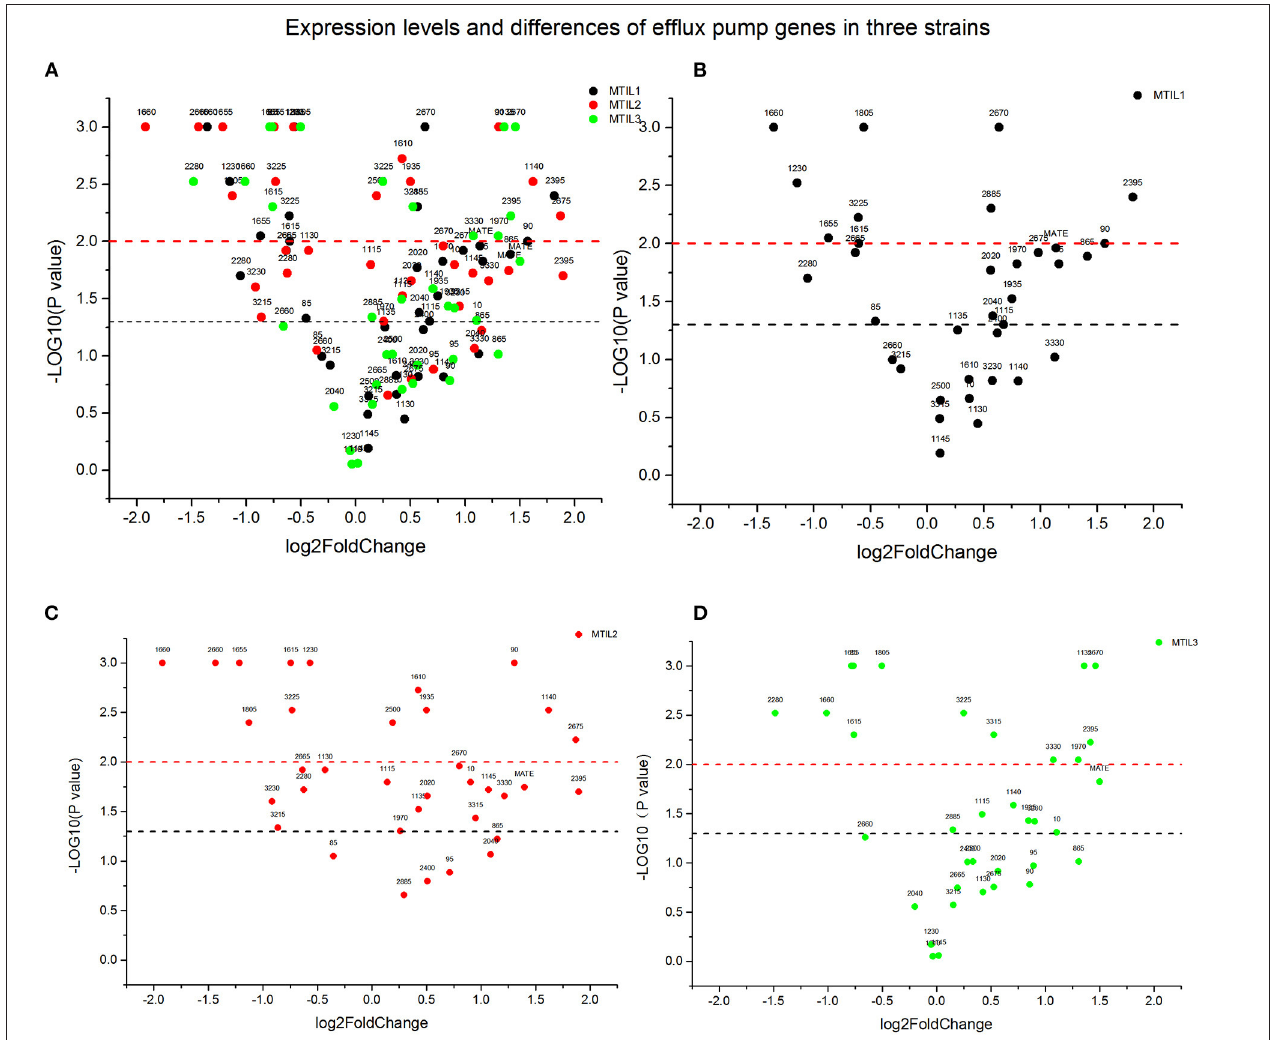
FIGURE 3 | Expression of genes associated with active efflux in the indicated strains. The Y -axis number represents the negative logarithm of the p -value (The black dash represents P -value = 0.05, significant difference; The red dash represents P -value = 0.01, extremely significant difference). The values of the X-axis are expression quantity. Strains MTIL1, MTIL2 and MTIL3 are represented by the black, red and green spots, respectively. The numbers above the spots represent the gene numbers (see Supplementary Table ). (A) Comparison of gene expression levels of efflux pump in three strains. (B–D) The efflux pump genes expression levels of the three strains were respectively